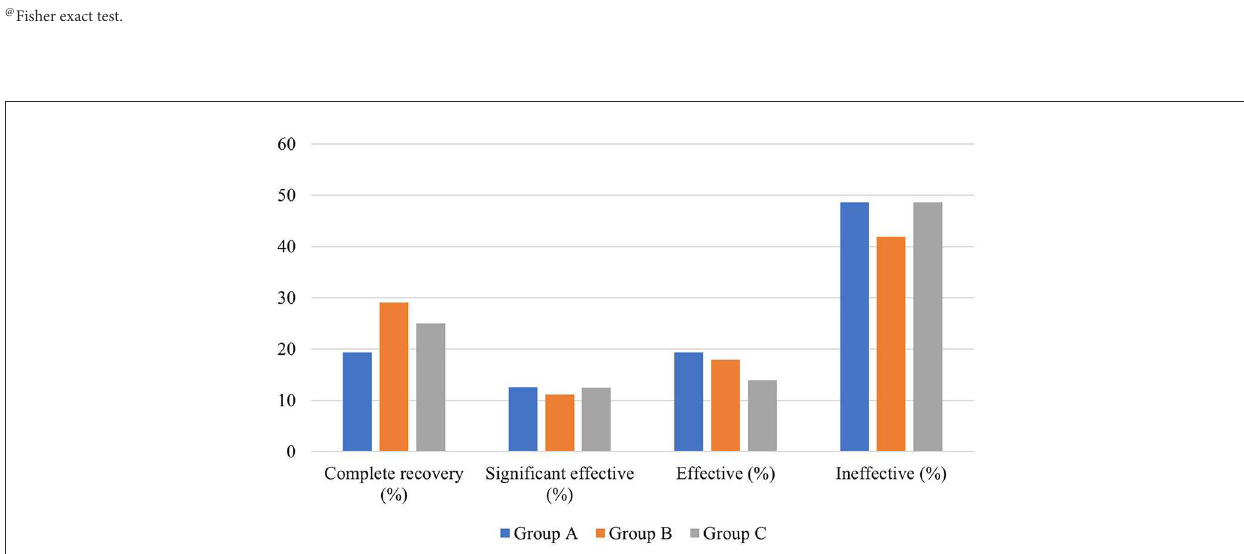
FIGURE7 Hearing efficacy of patients with flat-type SSNHL in the three